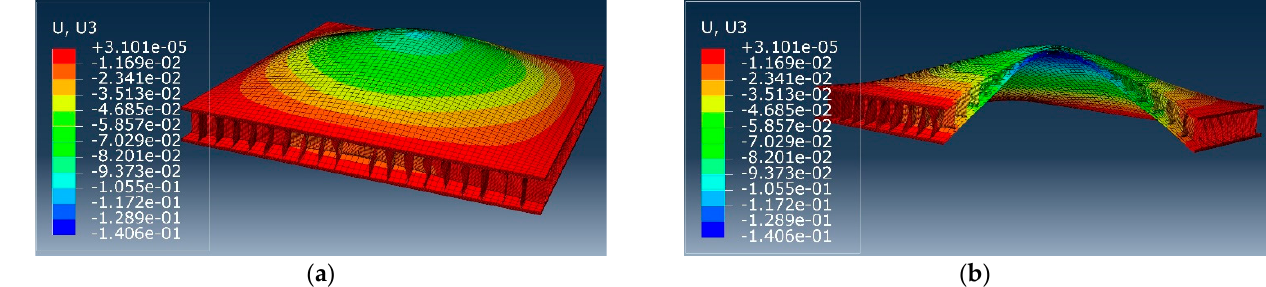
Figure 8. Square honeycomb panel ( a ) full model view ( b ) slice cut view.